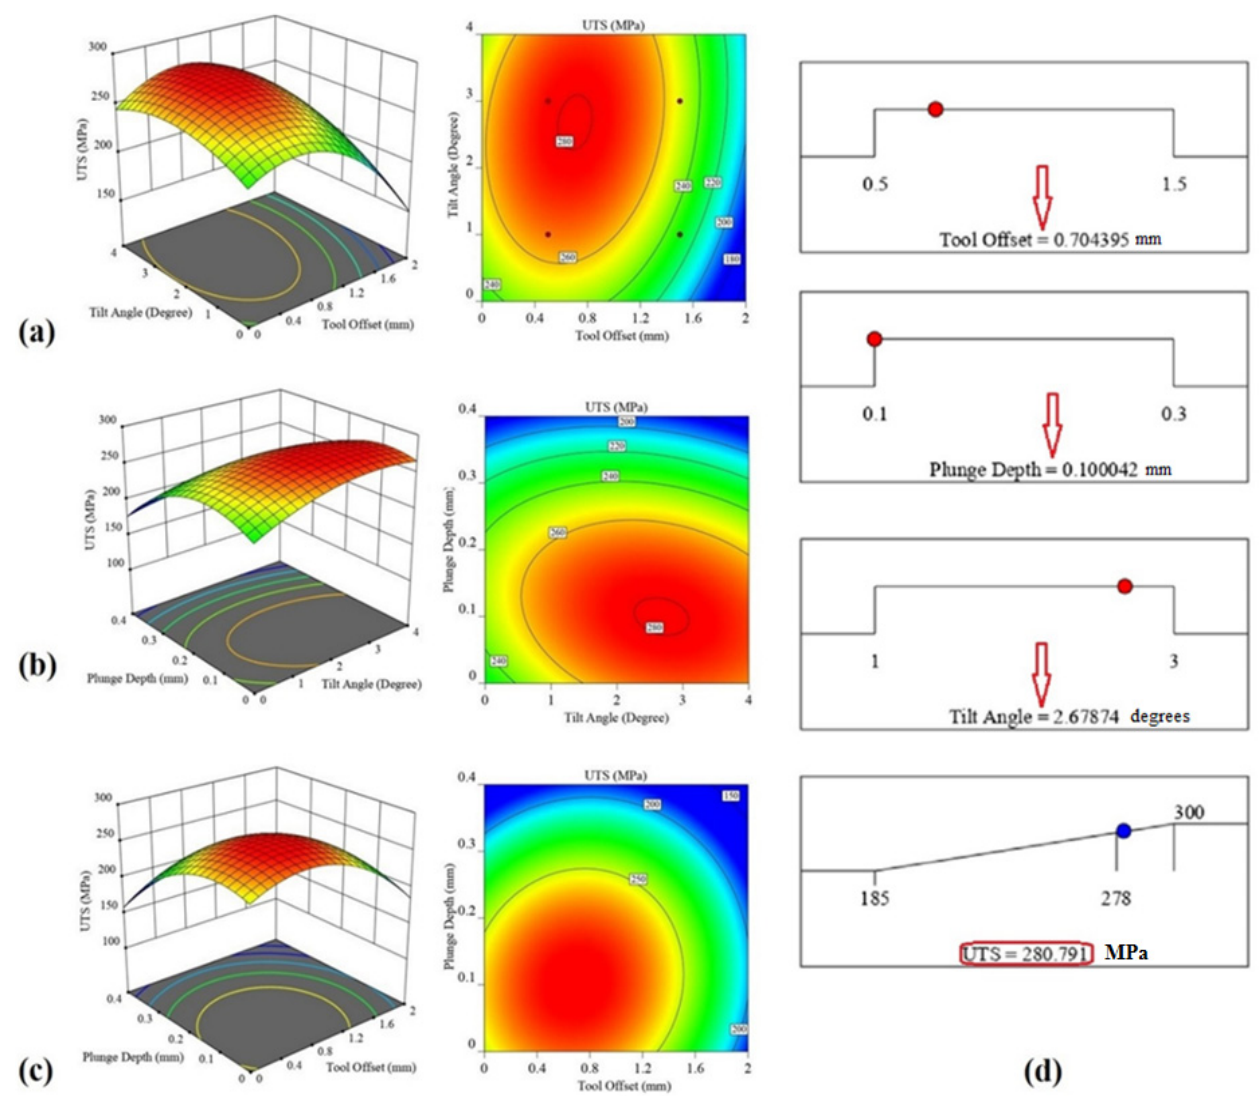
Figure 10. Three dimensional and contour plots of ( a ) tool offset and tilt angle effects on UTS, ( b ) plunge depth and tilt angle effects on UTS, ( c ) plunge depth and tool offset effects on UTS, ( d ) optimum values of main variables.